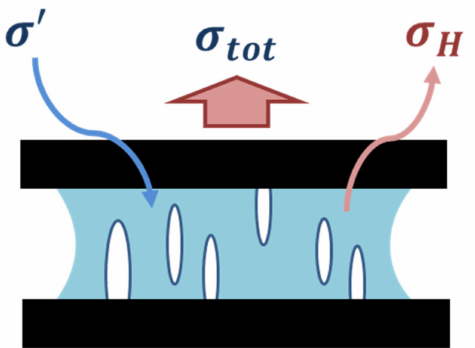
Figure 4. Schematic of change in hydrostatic σ H and deviatoric σ (cid:48) stress due to the mechanism of cavitation, cavity growth, and fibrillation. Cavity initiation and growth decreases the geometric confinement of the adhesive layer, thus decreasing σ H and allowing a compensatory increase in σ (cid:48)